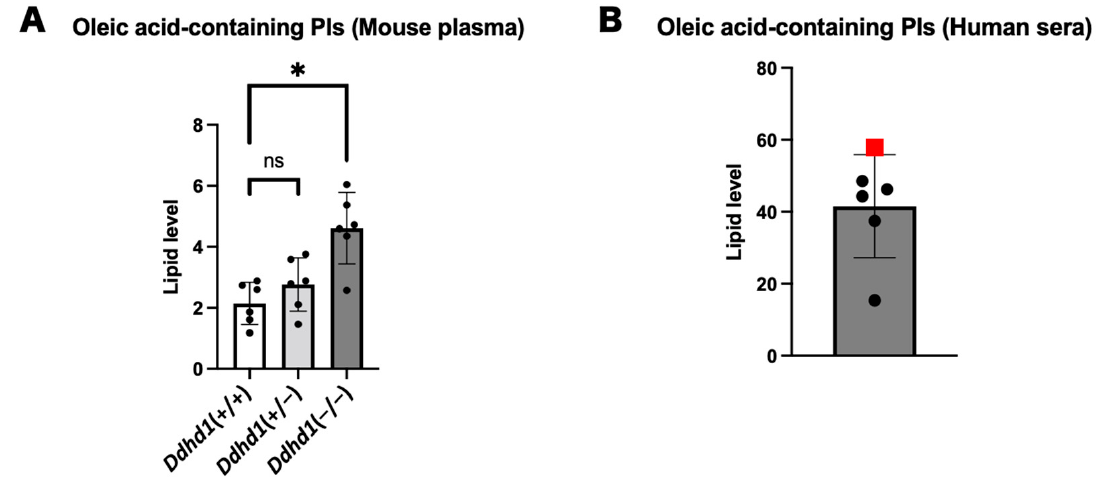
Figure 5. PIs and LPAs containing oleic acid. ( A ) Total oleic acid‑containing PIs in plasma from mice. ns: not significant. The data were analyzed by Dunnett’s multiple comparison test. ( B ) Total oleic acid‑containing PIs in human sera. The data point of SPG28 is represented by a red square. The unit of the vertical axis is pmol/mg. Error bars indicate mean ± SD. *: p <